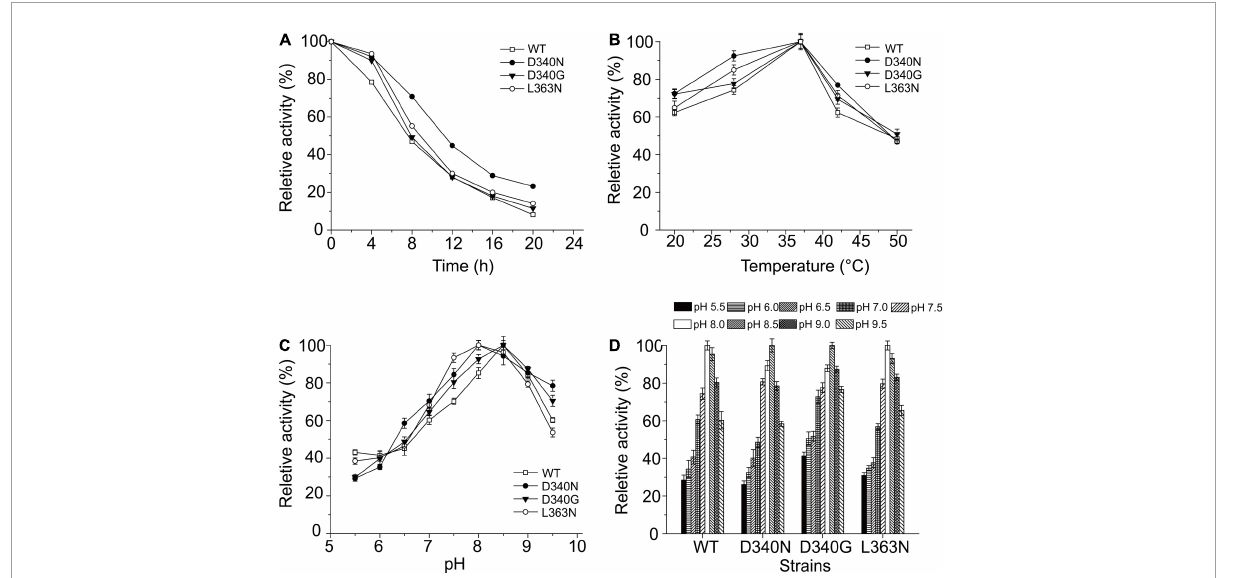
FIGURE3 The influence of reaction temperature and pH on the wild type and mutants with L -leucine as substrate. (A) Thermal profiles of wild-type (WT) and mutants L -amino acid deaminase ( L -AAD). (B) The optimal temperature of L -AAD and its mutants. (C) The optimal pH of L -AAD and its mutants. (D) The pH stability of L -AAD and its mutants. The maximal value of catalytic activity was defined as 100%. Error bars represent SD.